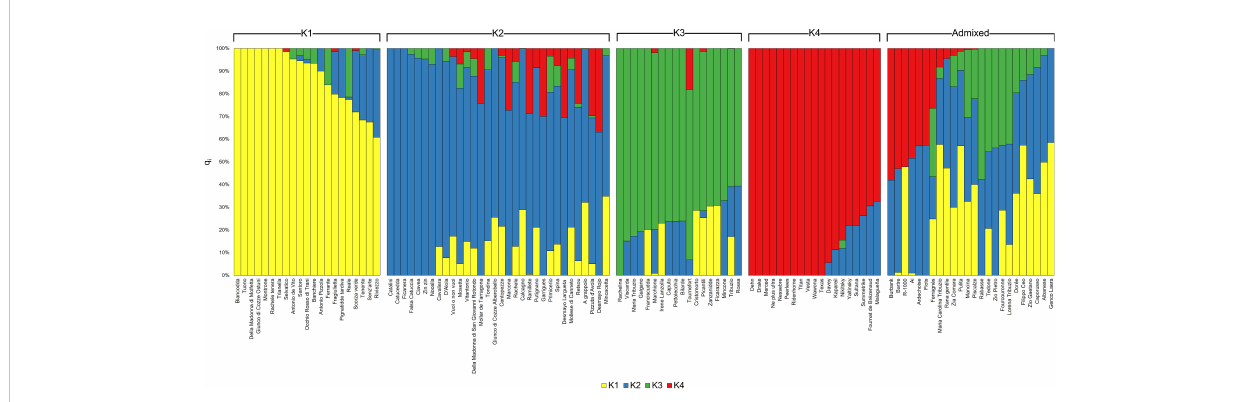
FIGURE 3 Results of ADMIXTURE population structure analysis for a model with four ancestral populations, named from K1 to K4. Each cultivar is represented by a vertical bar. In turn, each bar is divided into segments whose length and color represent the proportion of the genome (qi) contributed by each ancestral population. Cultivars assigned to one of the ancestral populations have a membership coef fi cient (qi) for that population >0.6. The remaining cultivars are assigned to the admixed